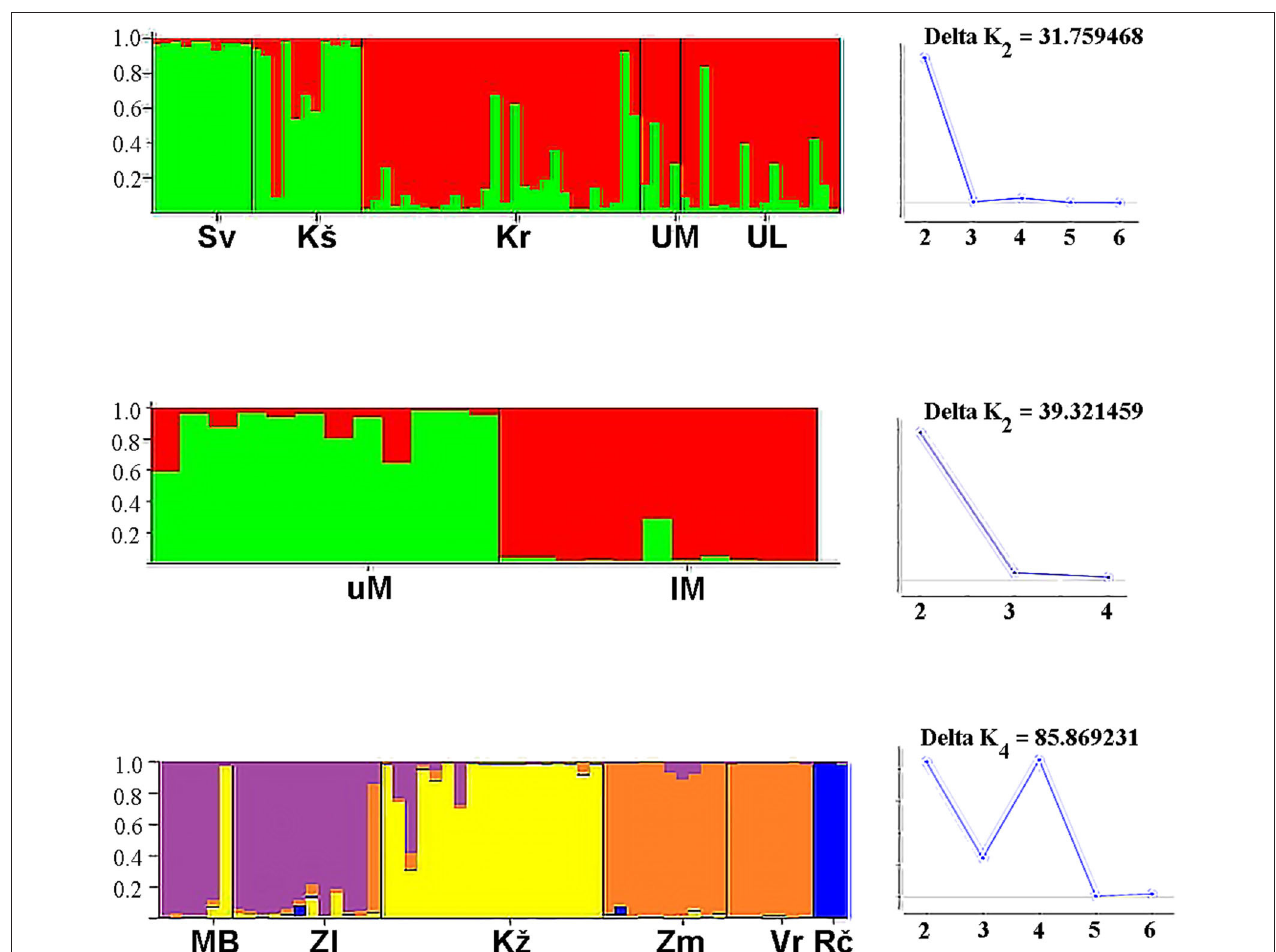
FIGURE 3 | STRUCTURE analysis of brown trout populations from the Una River catchment (top), Mrtvica River (in the middle), and streams in the Iron Gate Gorge area (bottom) (Sv, Svetinja River; Kš, Krušnica River; Kr, Krka River; UM, Una River at Martinbrod; UL, Una River at Loskun; uM, upper Mrtvica River; lM, lower Mrtvica River; MB, Mala Boljetinska River; Zl, Zlatica River; KŽ, KoŽica River; Vr, Vratna River; Zm, Zamna River; R ˇ c, Re ˇ cka